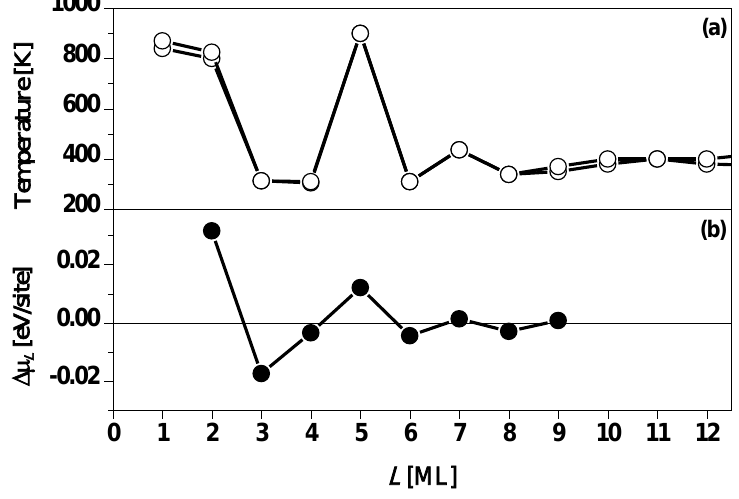
points are shown for several thicknesses as an indication of the degree of reproducibility. (b) Stability index ∆µ versus L from DFT calculations. Adapted from [33] (Copyright L American Physical Society 2003).